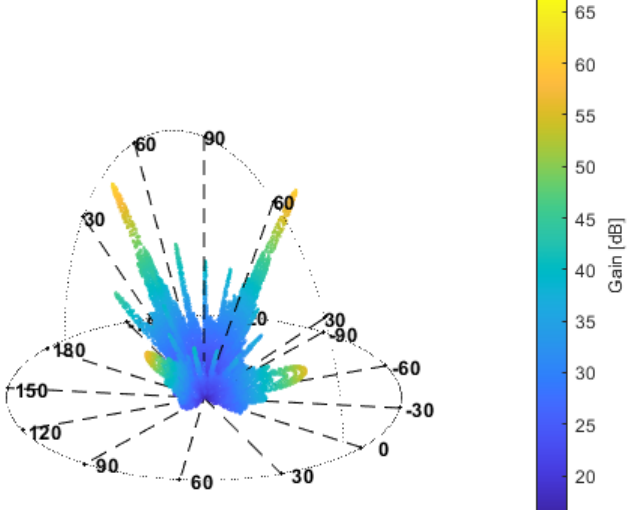
Figure 13. Beam pattern of the LOFAR station with the beam steered at φ st = 8 ◦ and θ st = 20 ◦